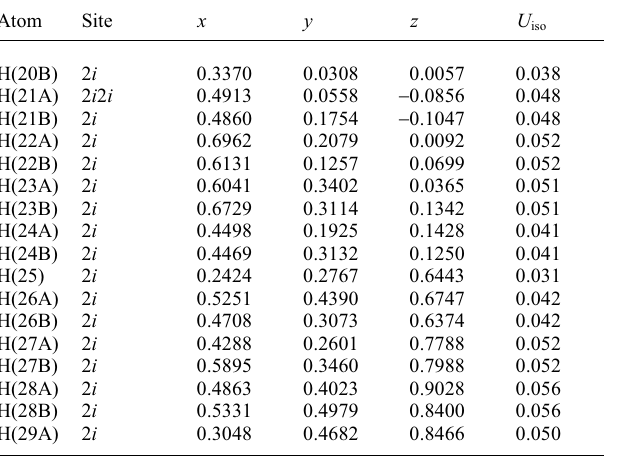
Table 3. Atomic coordinates and displacement parameters (in Å 2 )